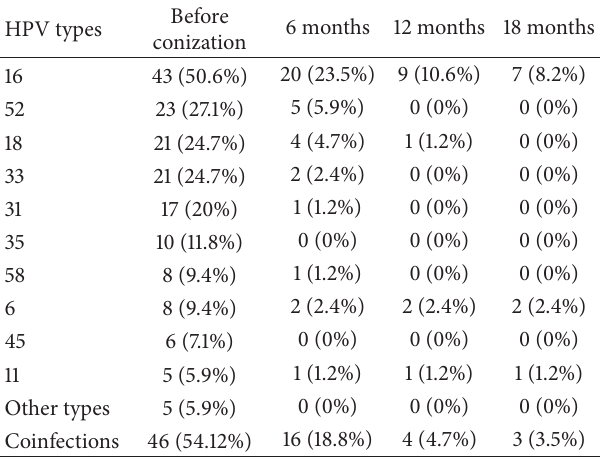
Table 1: The rate of persistence at 6, 12, and 18 months for each HPV type computed for all 85